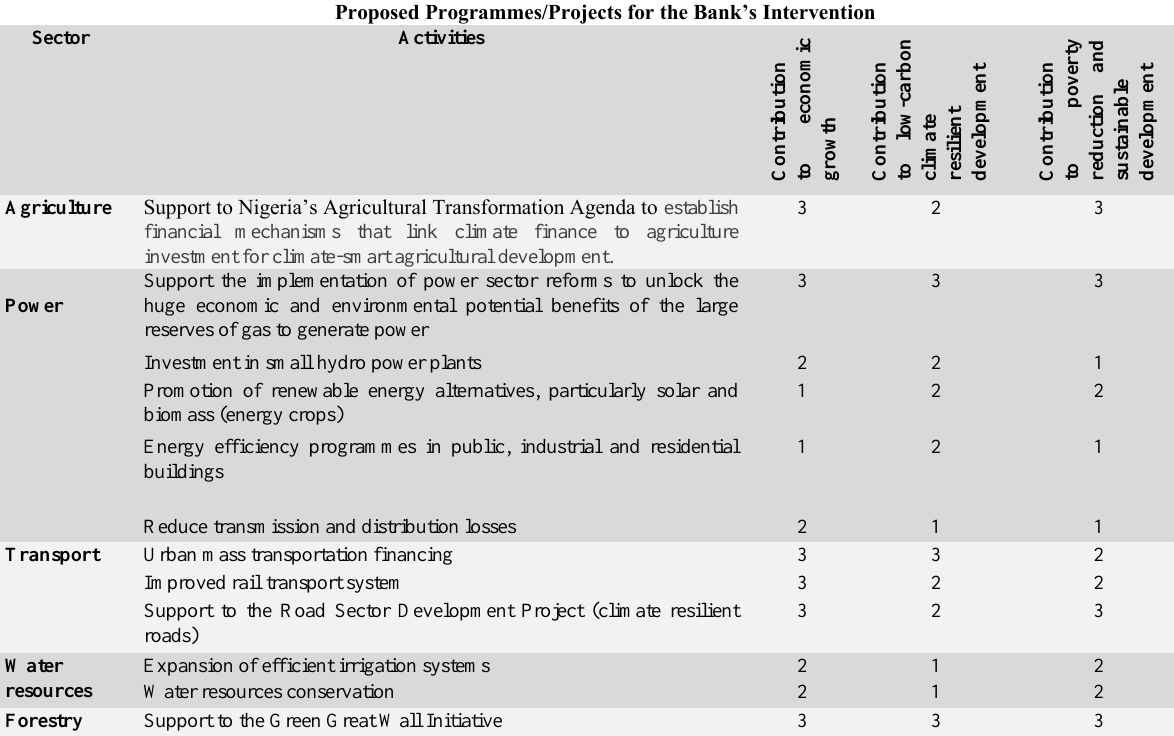
Table 3 Proposed Programmes/Projects for the Bank’s